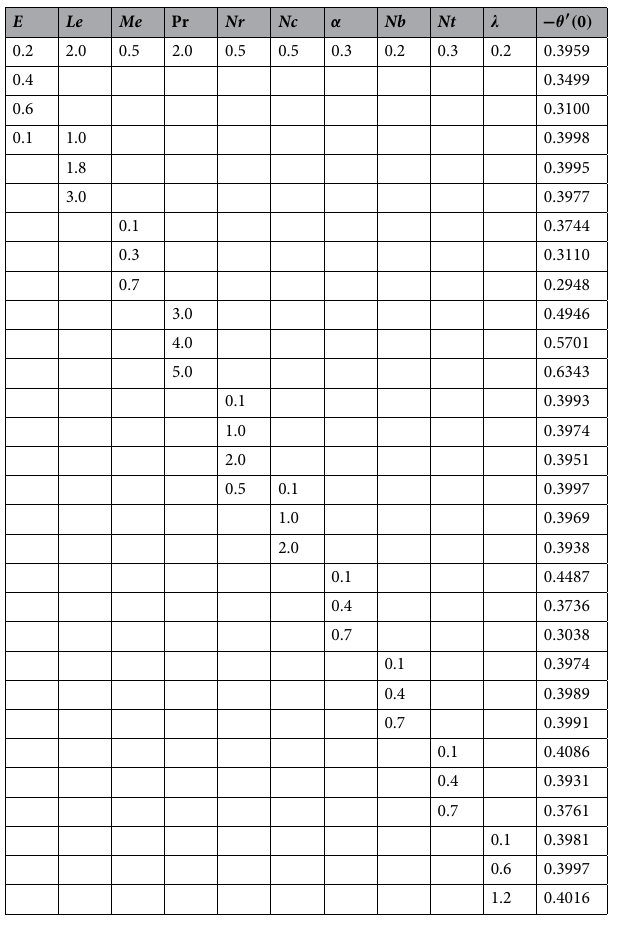
Table 2. Solutions of physical parameters via − θ ′ ( 0 )